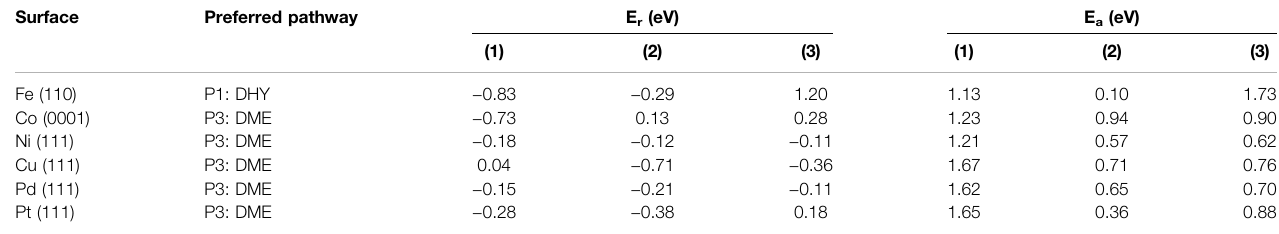
TABLE 2 | Reaction (E r ) and activation (E a ) energies (in eV) for the most feasible pathways on the six transition metal surfaces included in this work. DHY and DME stand for dehydroxylation and demethylation pathways, respectively. Surface